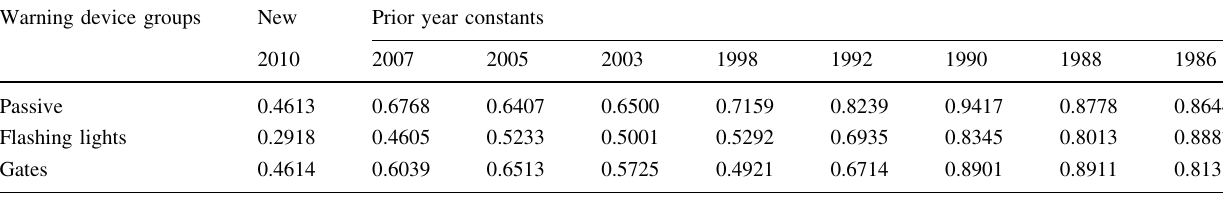
Table 6 Values of the normalizing constants for the accident prediction and resource allocation procedure Warning device